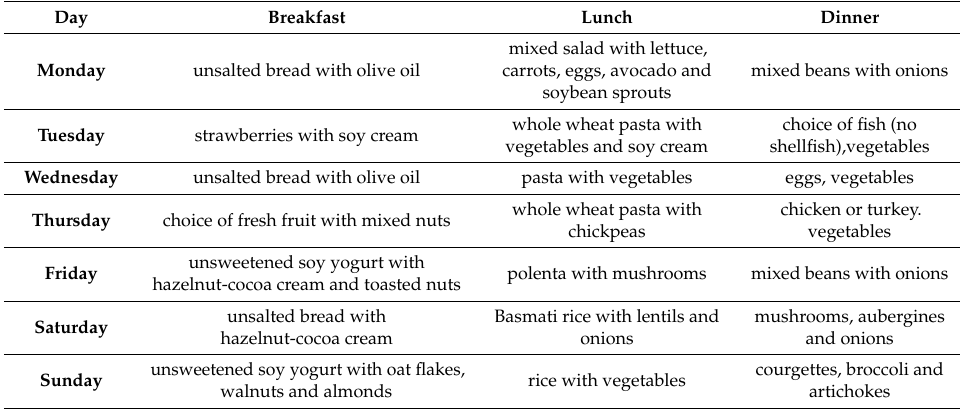
Table 3. Examples of menus in the second weight-loss, maintenance phase: a modified LPD-KA diet with 3 meals per week with unrestricted amounts of animal-derived proteins.